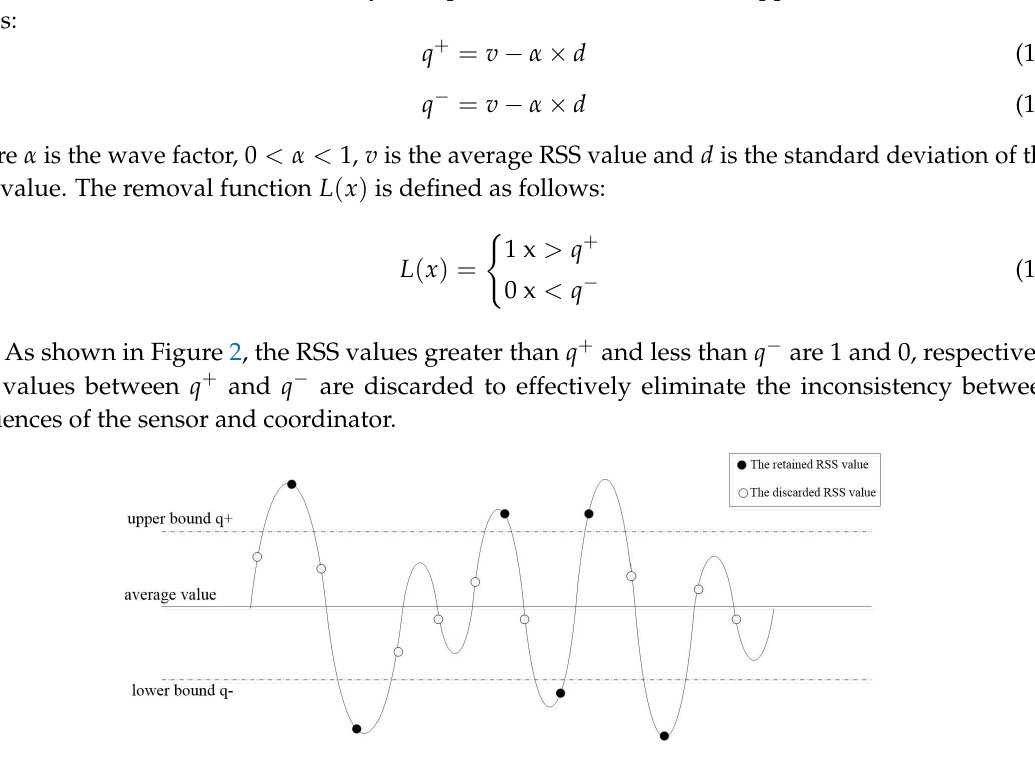
Figure 2. RSS filter